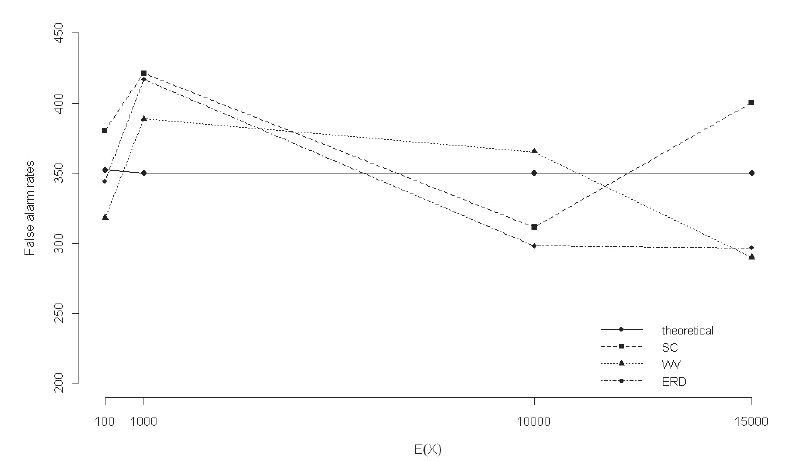
Figure 4 – Estimated ARLs for   =